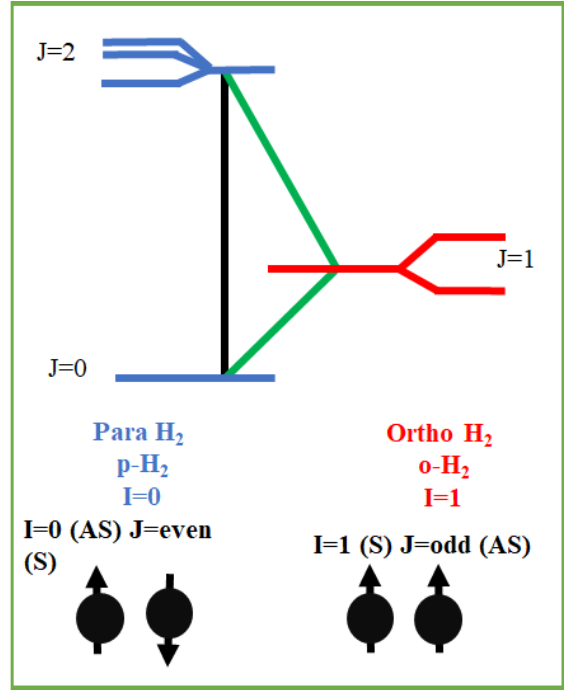
Fig. 2 . Nuclear rotation and spin manifold in the 1  g fundamental ground state where the Ortho manifold associates the rotational J Odd states to the even spin triplets: I=1 whereas the Para J Even ones are associated to the odd spin singlets I = 0 (Only the first three levels are represented).